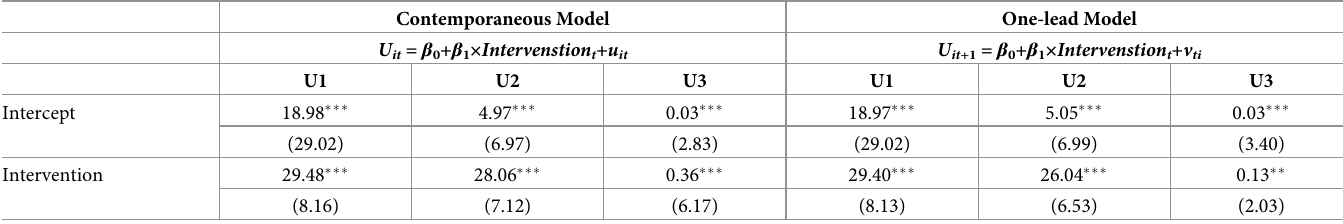
Table 5. Uncertainty average on the day of and the day following